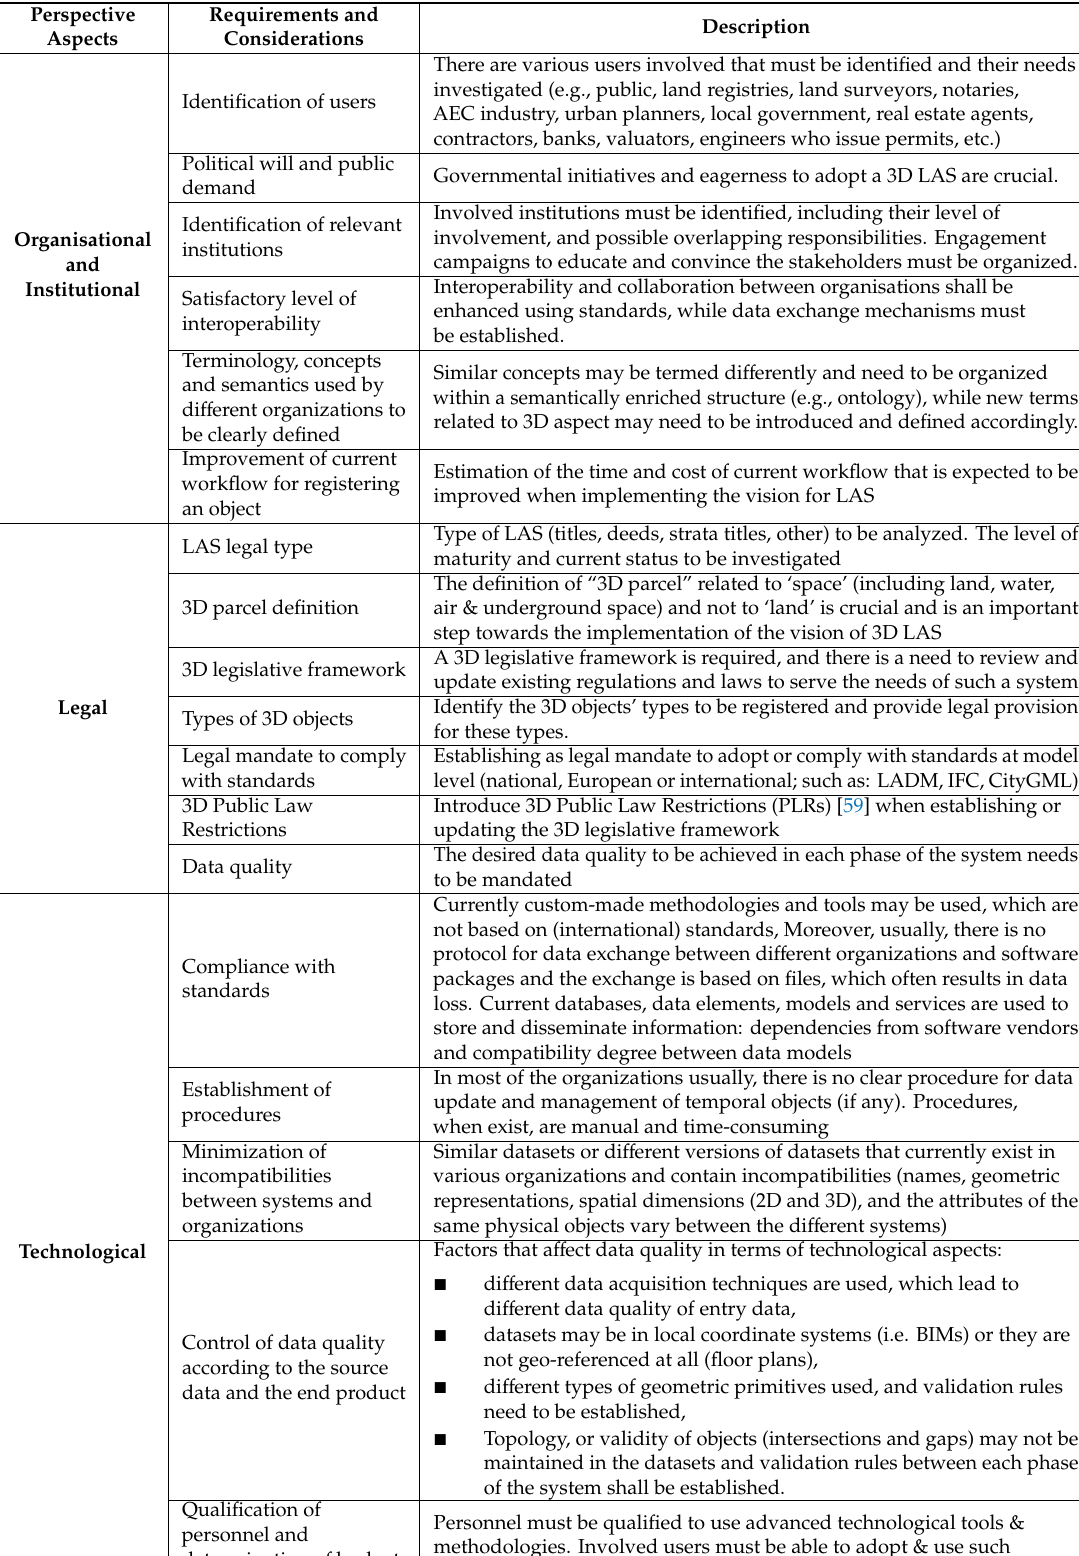
Table 1. Requirements and considerations for the implementation of the vision of 3D LAS. Perspective